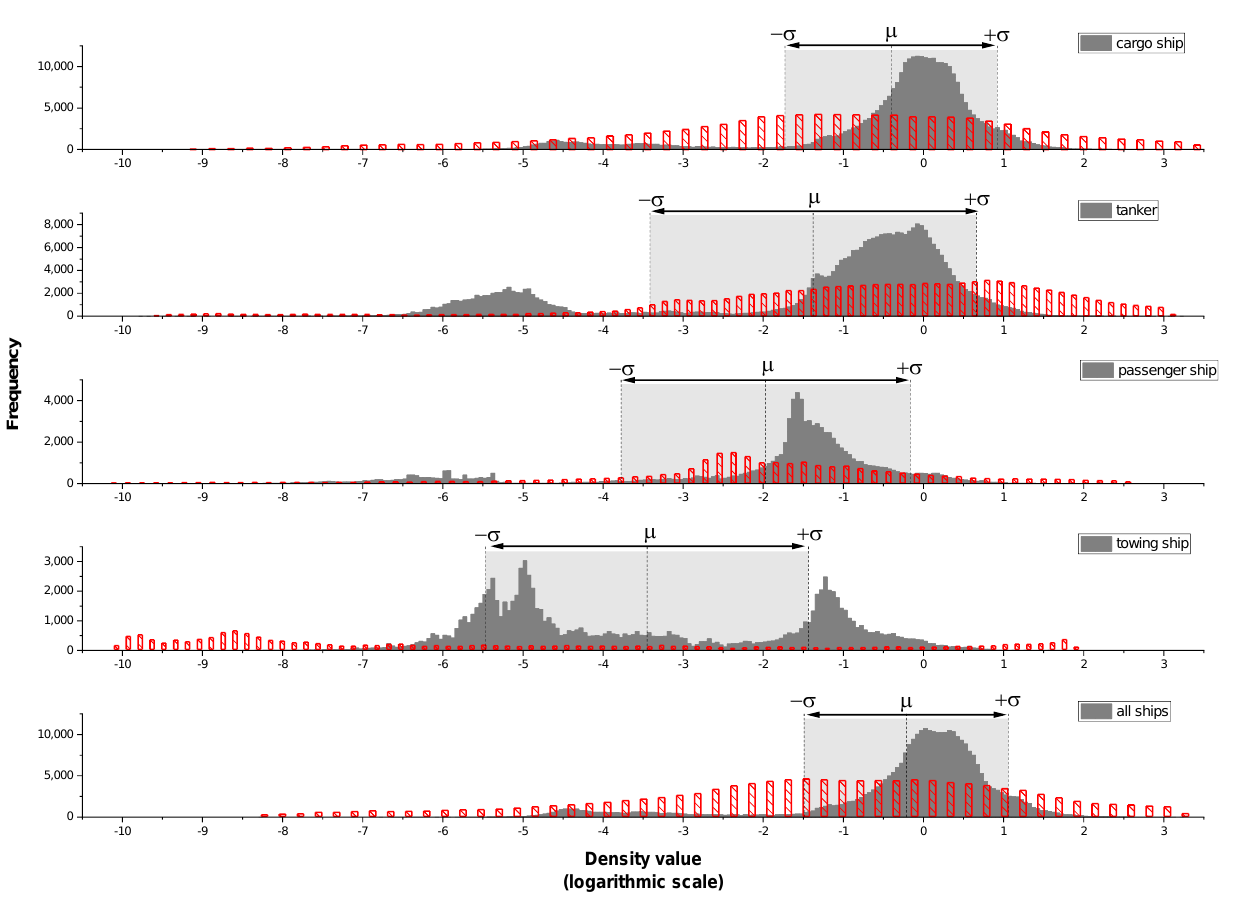
Figure 5. Histograms of logarithmically transformed density values representing raster pixel values. The red histogram shows the linear redistribution of the values originally lying between -1 standard deviation and +1 standard deviation from the mean over the entire observed range.